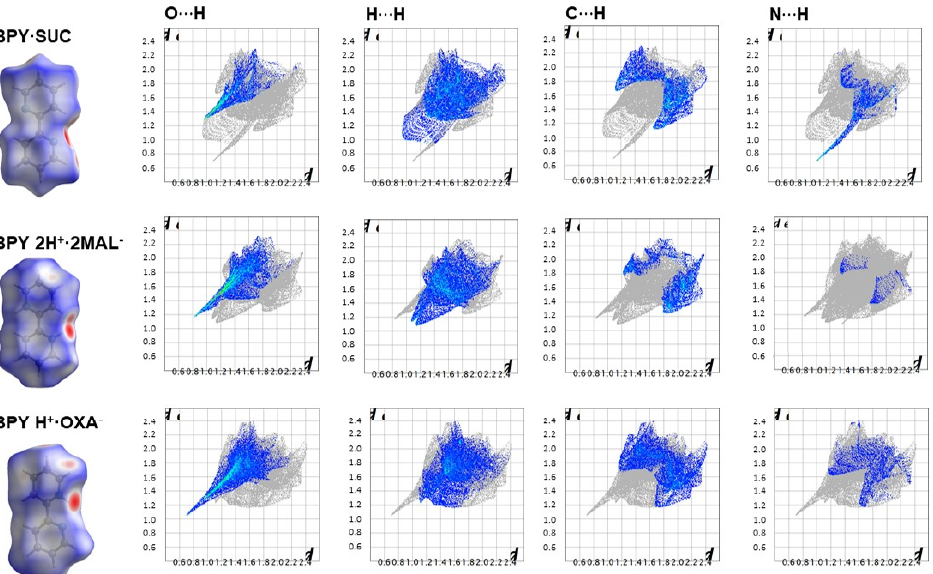
Figure 4. 2D fingerprint plots of BPY · SUC, BPY 2H + · 2MAL − and BPY H + · OXA − showing the O ··· H, H ··· H, C ··· H, and N ··· H